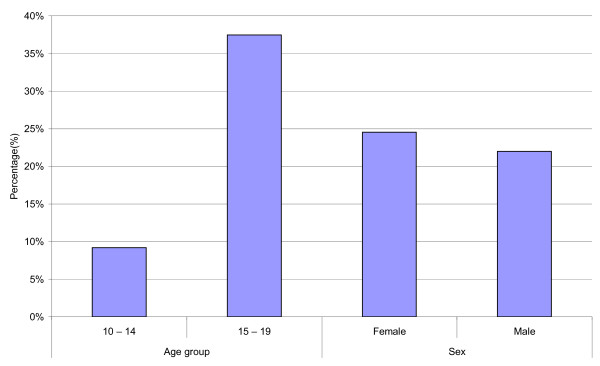
Percentage distribution of 143 sexually active adolescents by age group and sex in four districts in Tanzania, 2008.